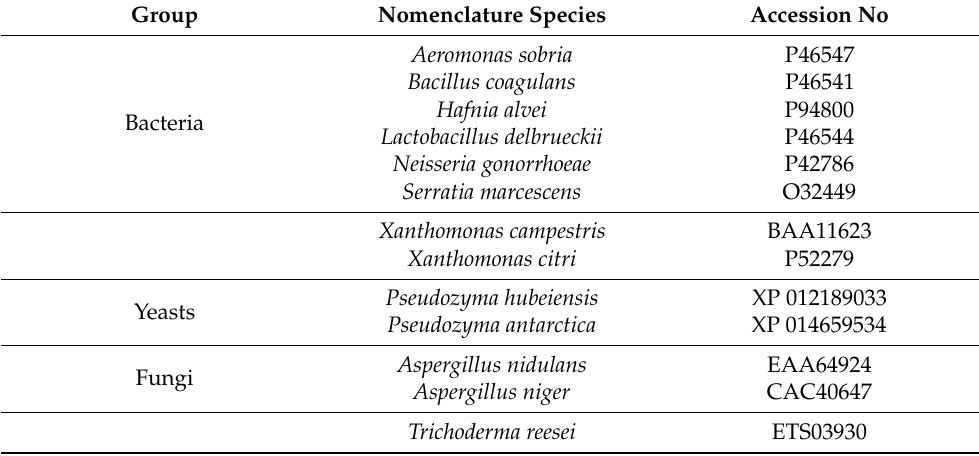
Table 3. List of proline iminopeptidase proteins used in the phylogenetic analysis.